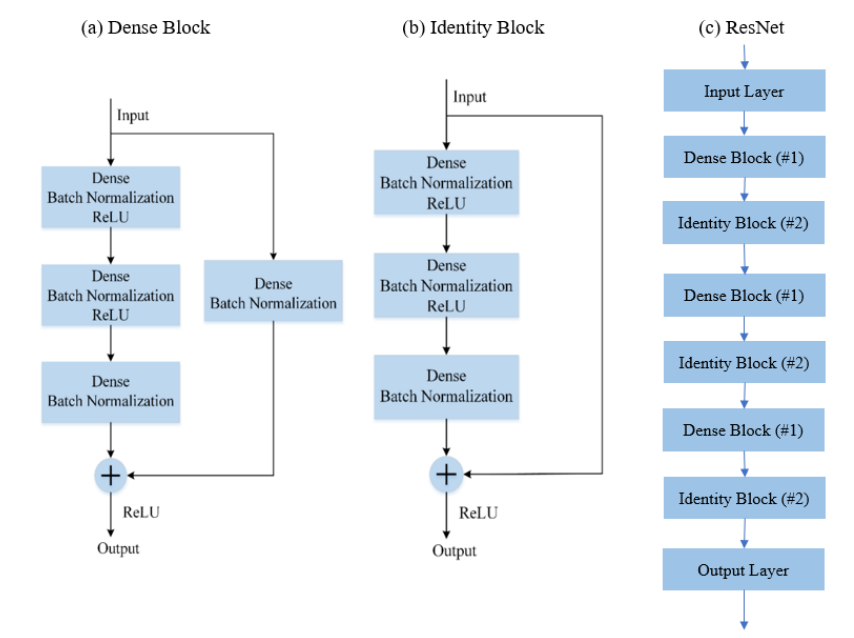
Figure 3. Simplified structure of ResNet.